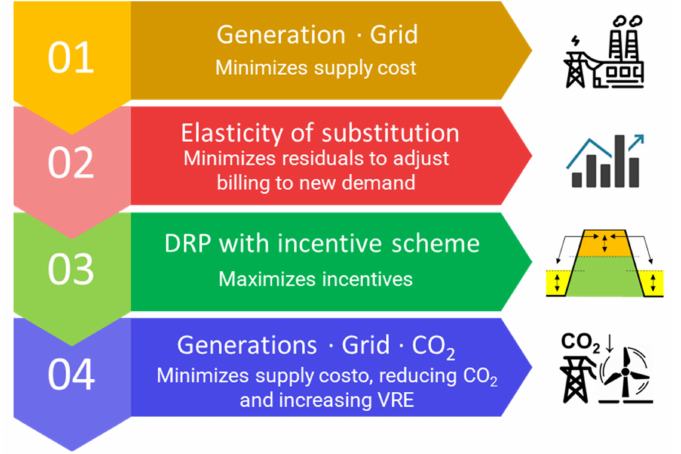
Figure 7. Sequential modeling